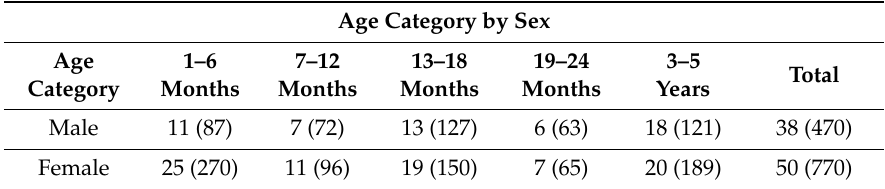
Table 2. Number of individual wild Asian calves sampled, by known sex and age category. Parenthesis = total number of 10 min focal video samples for that age-sex class. Total N calves = 101, median N focals per calf = 2, range = 1–5 across age